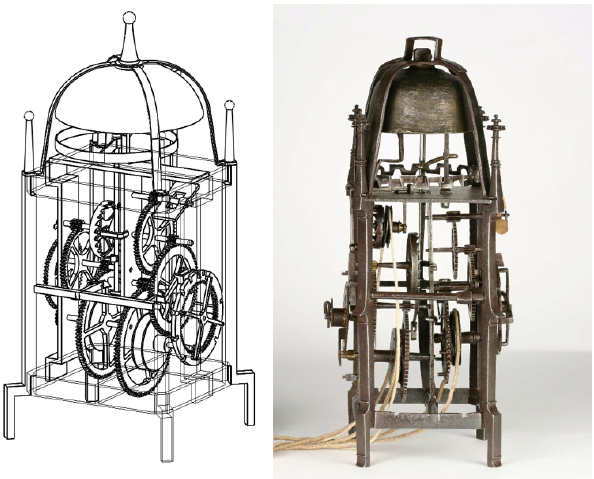
Figure 17. N6 – Central European iron chamber clock (German Watch Museum Furtwangen,